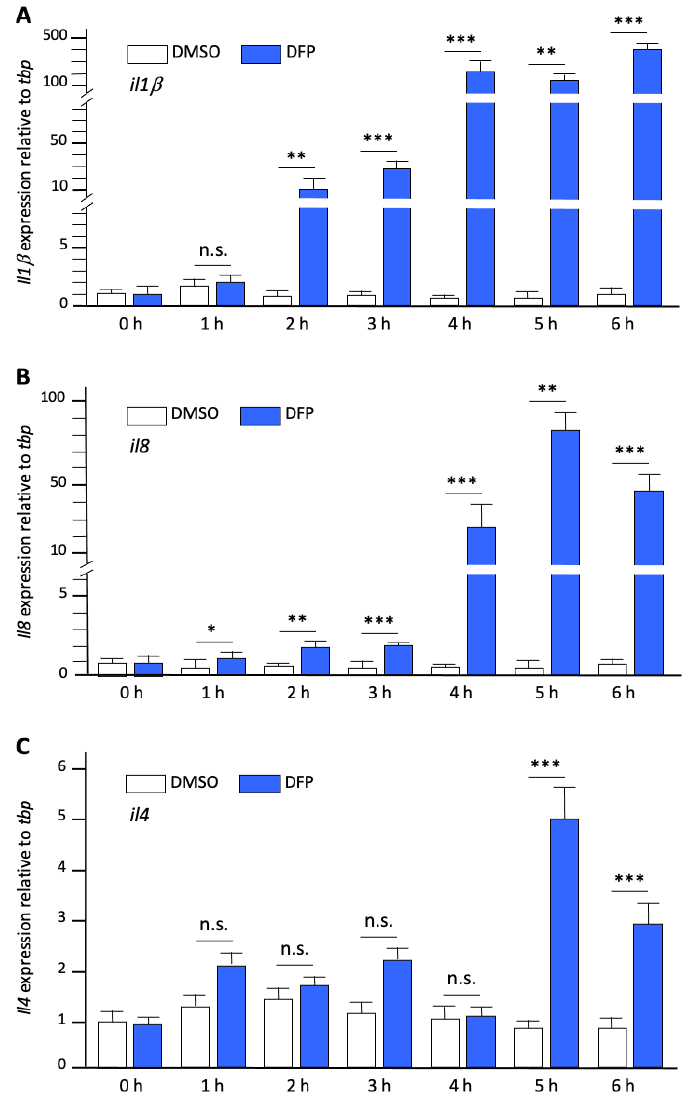
Figure 3. DFP exposure induced massive expression of pro-inflammatory cytokines ( A – C ). Expression levels of transcripts encoding cytokines Il1 β ( A ), Il8 ( B ), and Il4 ( C ) relative to that of reference tbp transcripts, in RNAs from control (DMSO) and DFP-exposed larvae (DFP) at different exposure times. In each condition, N = 8 samples, n = 7 larvae/sample. Error bars on all graphs represent the standard error of the mean (SEM). Statistics: *, p < 0.05; **, p < 0.01; ***, p < 0.001; n.s., not significant. To verify that the massive overexpression of RNAs encoding pro-inflammatory cy- tokines observed in DFP-exposed larvae did reflect brain inflammation, we next investi- gated, by qRT-PCR analysis of RNAs extracted from dissected brains, the expression levels of transcripts encoding the same set of cytokines ( Il1 β , II8 , and Il4 ) in larvae exposed for 6 h to either DMSO or DFP. Results confirmed that a 6 h DFP exposure induced massive expression of il1 β (fc: 189 ± 37, p < 0.01) and il8 (fc: 42 ± 19, p < 0.05), and